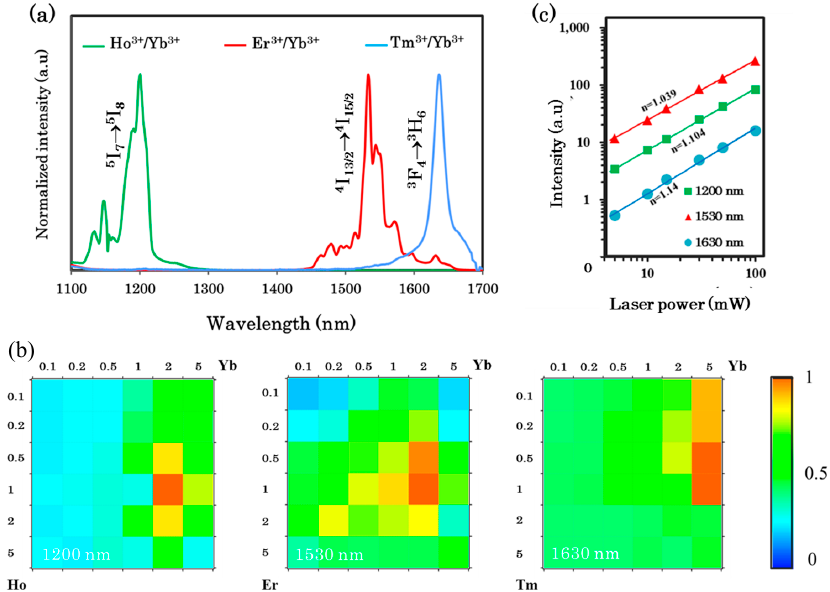
Figure 4. ( a ) Normalized emission spectra in the NIR region of Gd 2 O 3 : Ho 1 mol %/Yb 2 mol % at 1200 nm, Gd 2 O 3 : Er 1 mol %/Yb 2 mol % at 1530 nm, and Gd 2 O 3 : Tm 0.5 mol %/Yb 5 mol% at 1630 nm; ( b ) The dopant composition dependence of the DC emission intensity; ( c ) Dual logarithmic plots of intensity versus excitation power of Gd 2 O 3 : Ho 1 mol %/Yb 2 mol % at 1200 nm, Gd 2 O 3 : Er 1 mol %/Yb 2 mol % at 1530 nm, and Gd 2 O 3 : Tm 0.5 mol %/Yb 5 mol % at 1630 nm, under 980 nm diode laser